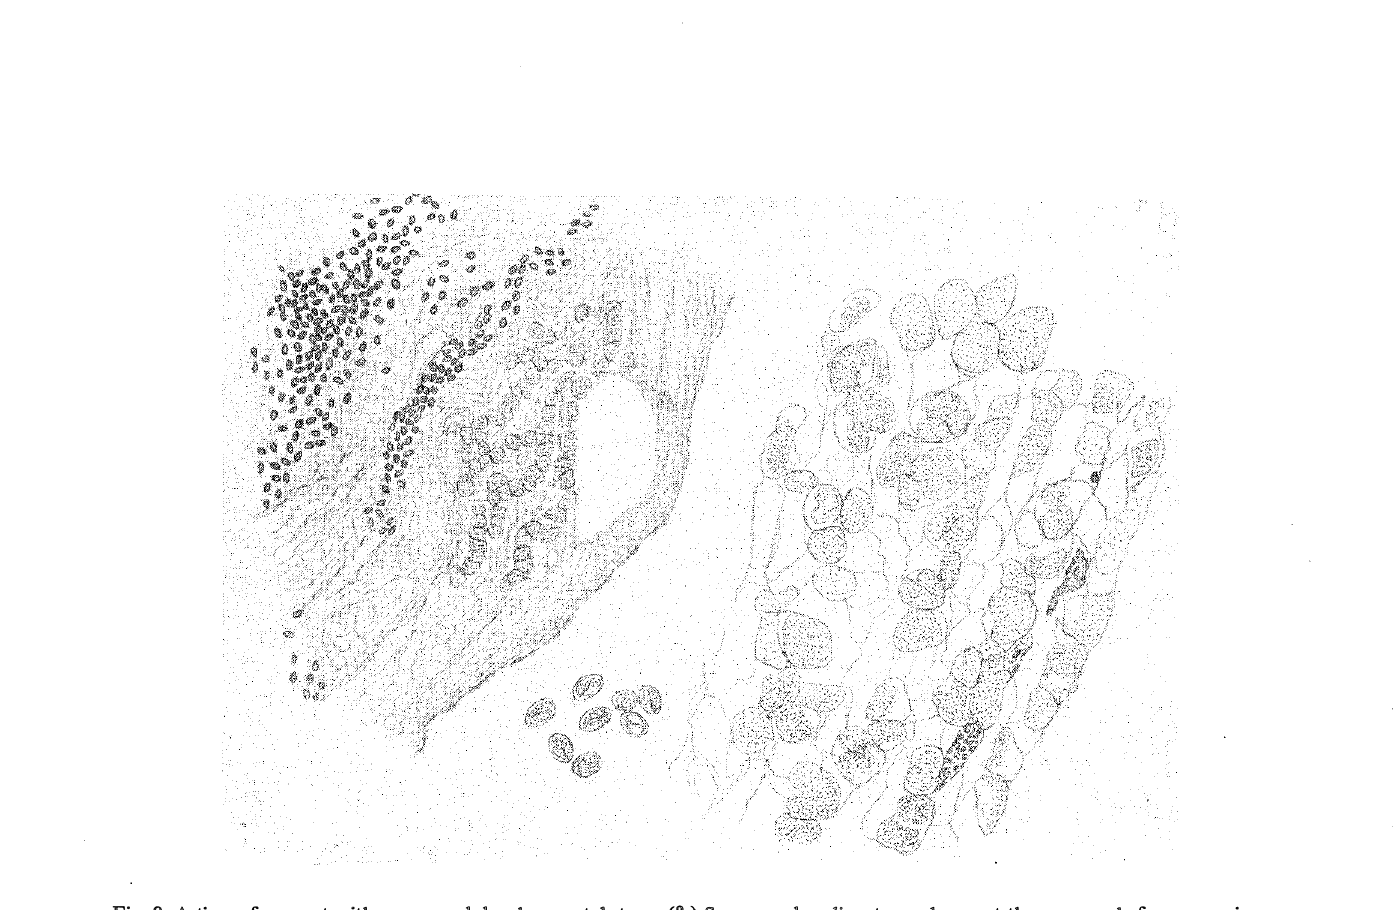
Fig. 8. A tissue fragment with spores and developmental stages(?) Spores and earlier stages shown. at the same scale for